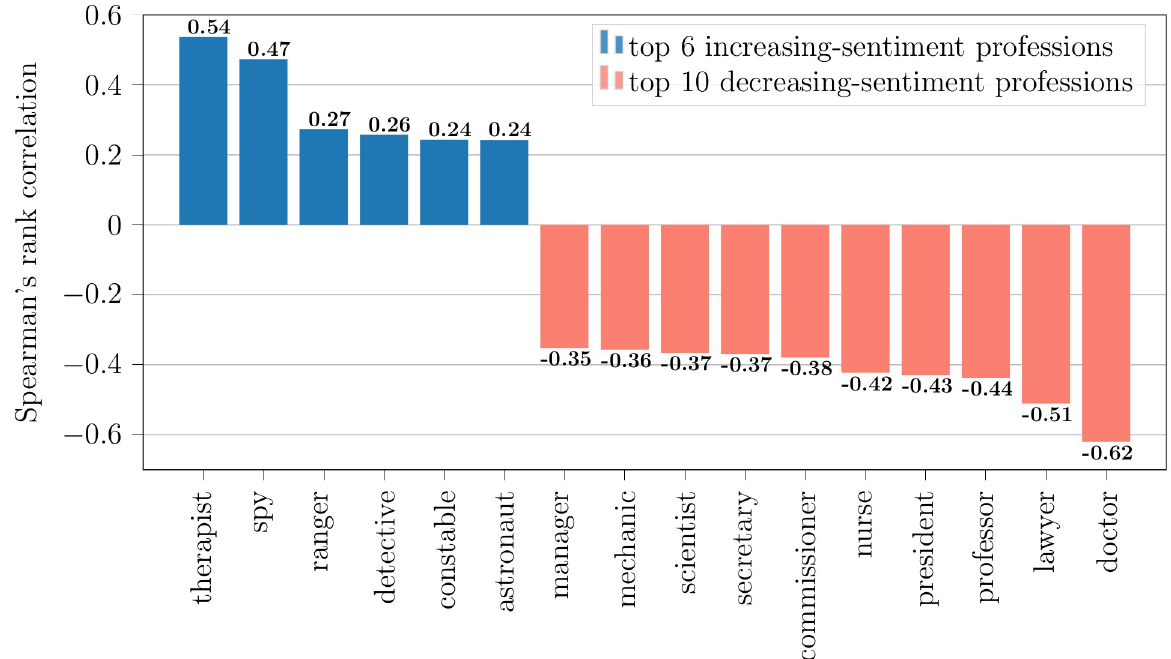
Fig 12. Professions with the top increasing and top decreasing sentiment trends. The blue-colored professions have the top 6 most positive Spearman’s rank correlation of proportion of positive mentions vs time. Therefore, the proportion of positive sentiment mentions shows increasing trend over time for these professions. The red-colored professions have the top 10 most negative correlation and their proportion of negative sentiment mentions is increasing over time.